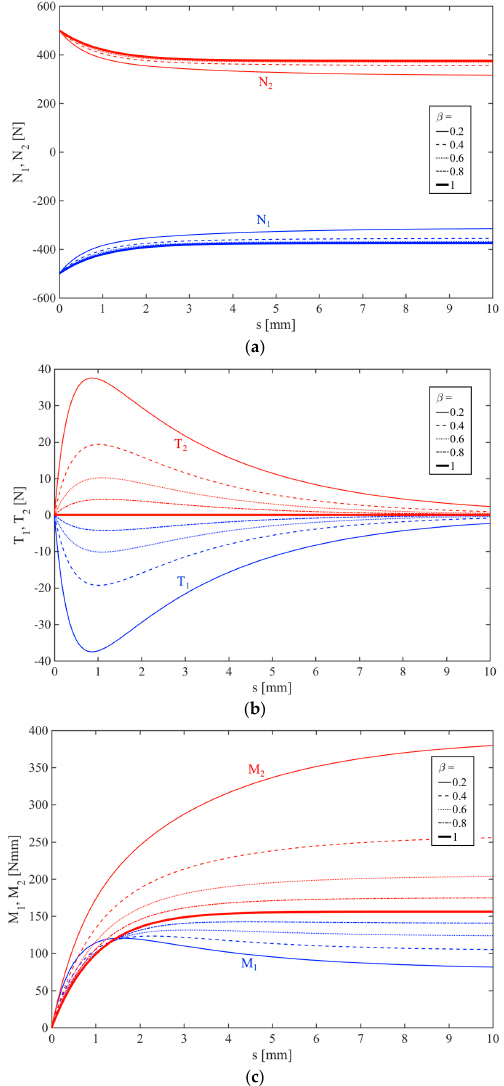
Figure 18. Effect of the mechanical ratio β on the static response of the sublaminates: ( a ) Axial force; ( b ) Shear force; ( c ) Bending moment. (Isotropic specimen).